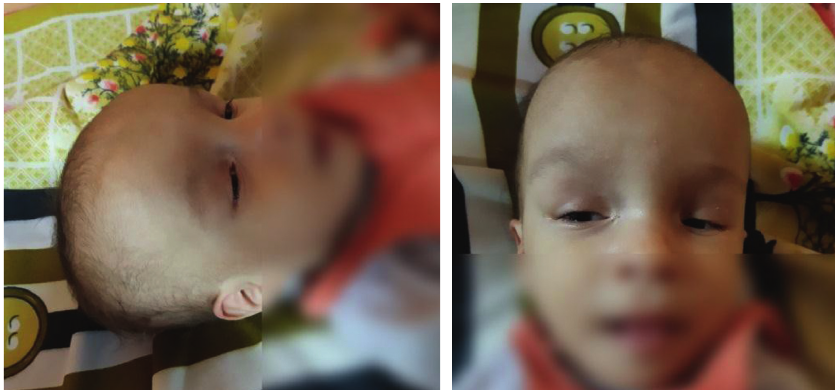
Figure 1: Photograph of the patient. The photo shows the syndromic features including high rounded eyebrows, a broad nasal bridge, and low set ears with bilateral symmetrical